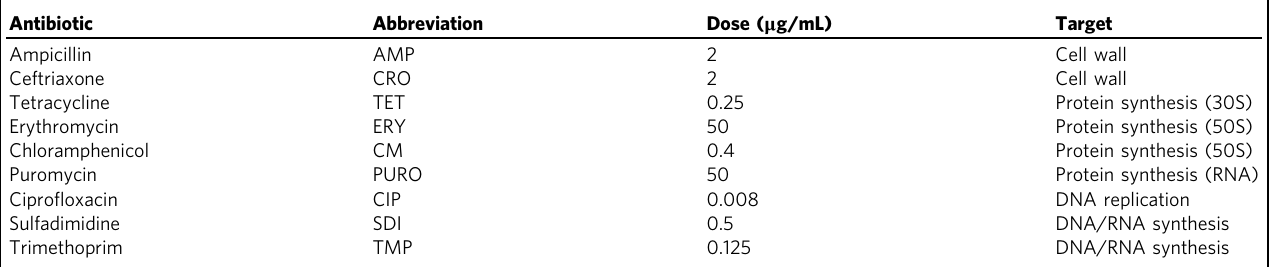
Table 2 The nine antibiotics investigated in this study and their working concentrations.